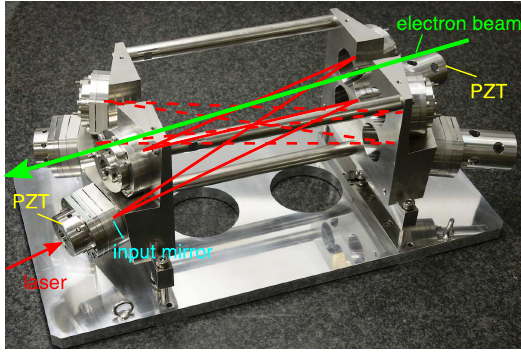
FIG. 8. The optical cavity